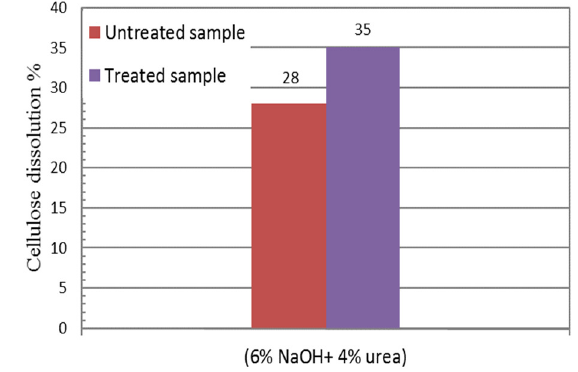
Fig. 8. Effect of temperature on cellulose dissolution at 8% alkaline solution.